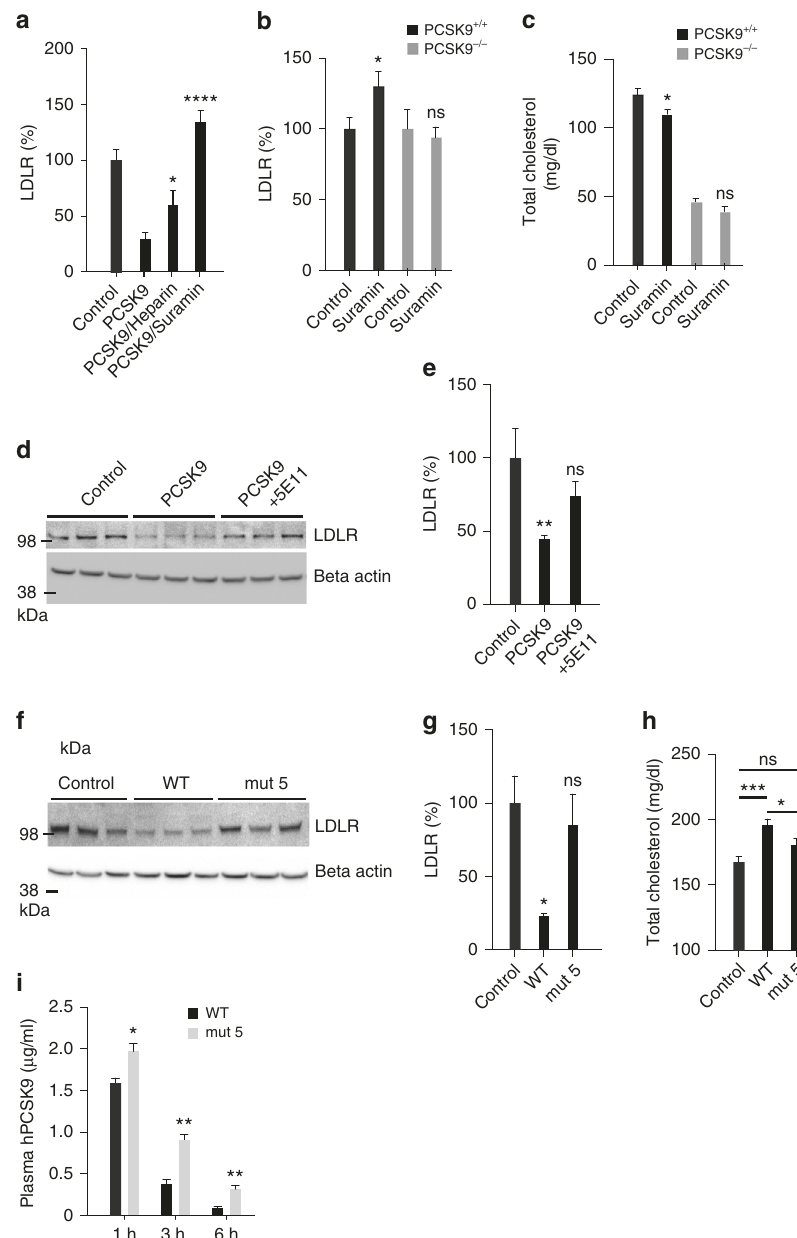
Fig. 7 Inhibition of PCSK9:HSPG interaction protects LDLR in vivo. a LDLR is protected in mice co-injected with PCSK9 (10 µ g) and heparin (500 µ g) or suramin (300 µ g) compared to mice injected with PCSK9 alone (control n = 15, PCSK9 n = 10, PCSK9/heparin n = 7, PCSK9/suramin n = 3). b , c A single injection of suramin (50 mg/kg) increased liver LDLR levels ( b ) and reduced total plasma cholesterol ( c ) 18 h later in WT mice (control n = 5, suramin n = 8) but not in PCSK9 KO mice (control n = 5, suramin n = 7). d , e Co-injection of PCSK9 (10 µ g) with mAb 5E11 (50 µ g) protects the LDLR from degradation (control n = 4, PCSK9 n = 7, PCSK9/mAb 5E11 n = 6). Representative blot is shown. f , g PCSK9 with mutated HSPG-binding site (mut 5) (10 µ g) is ineffective in inducing LDLR degradation ( n = 3 of each). h PCSK9 but not PCSK9 mut 5 signi fi cantly increases total cholesterol in mice fed Western-type diet 6 h post injection (control n = 25, PCSK9 n = 12, PCSK9 mut 5 n = 9). i Injected PCSK9 mut 5 remained in circulation for a prolonged time compared to PCSK9 WT in line with reduced capture by HSPG and clearance by LDLR. Bar graphs show mean with s.e.m. error bars. Statistical signi fi cance was evaluated using a two-tailed Student ’ s t -test. Supplementary Fig. 11 shows uncropped gel